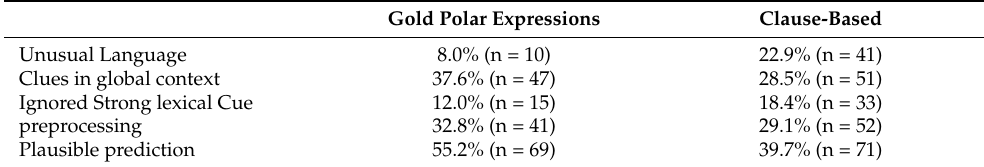
Table 11. Manual error category frequencies for gold polar expression polarity and clause-based polarity test set